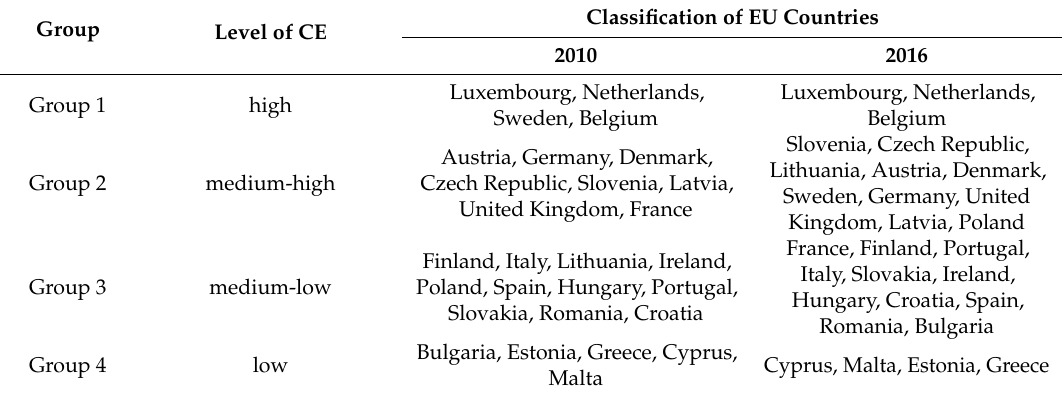
Table 4. Classification of EU countries for CE development level ( MS G Group Level of CE